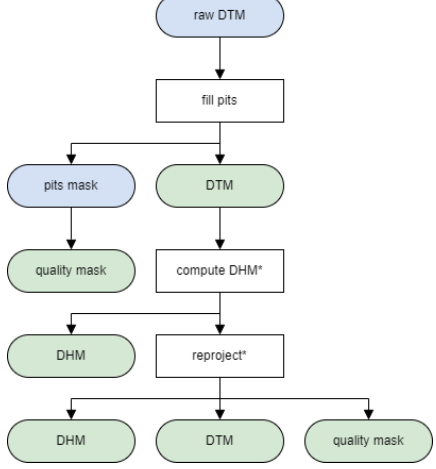
Figure 11. Bulldozer post-processing simplified pipeline chart (Blue: intermediate products, Green: outputs, *: optional